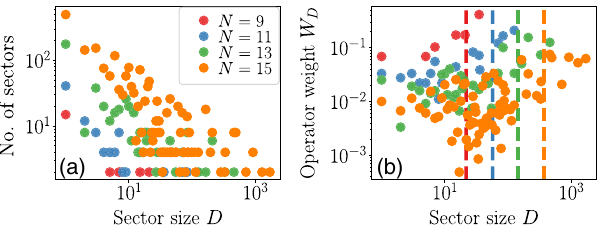
FIG. 12. (a) Distribution of sector sizes D with H i ⊂ H the Hamiltonian H 3 . (b) Operator weight distribution W D . Both plots are similar to the full distributions shown in the main text. The vertical dashed lines in (b) indicate the average sector size, which grows exponentially in system size but is nevertheless exponentially smaller than the largest sector.